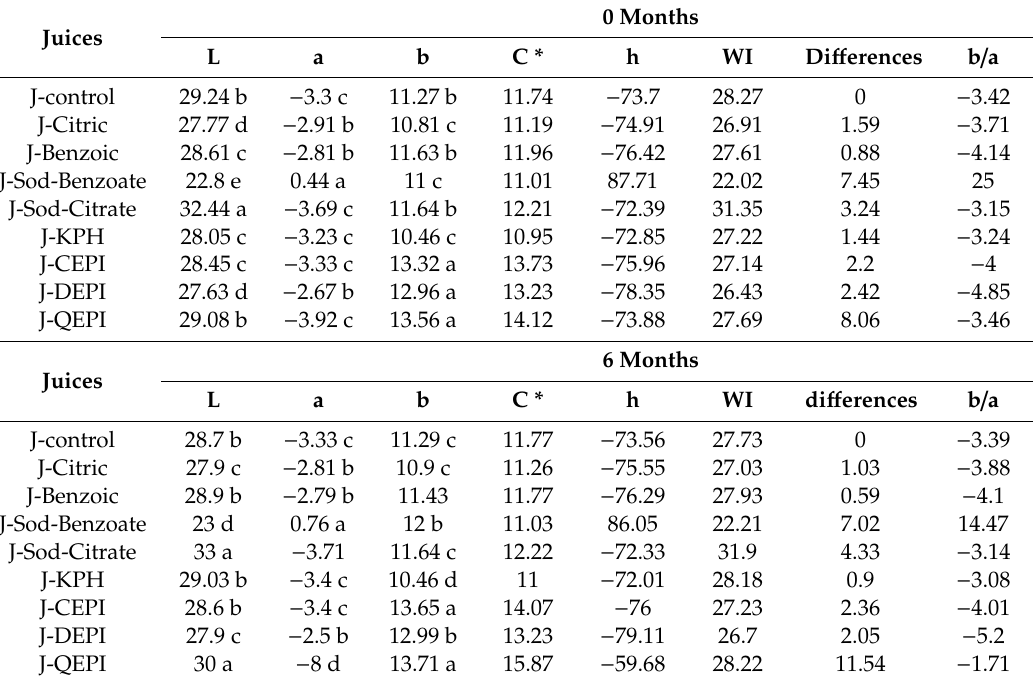
preparation. The color faded and flavor declined gradually with the increase of storage period at room conditions. Juices five, six, seven, and eight were the best in color stability and overall acceptability, and juice nine was the worst-rated